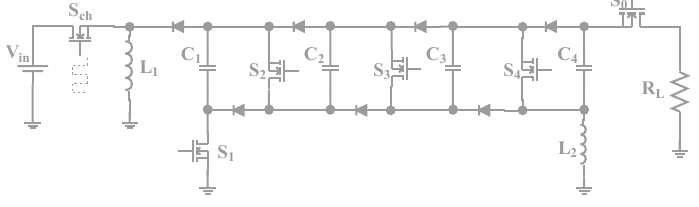
Figure 5. Phase 2: waiting.